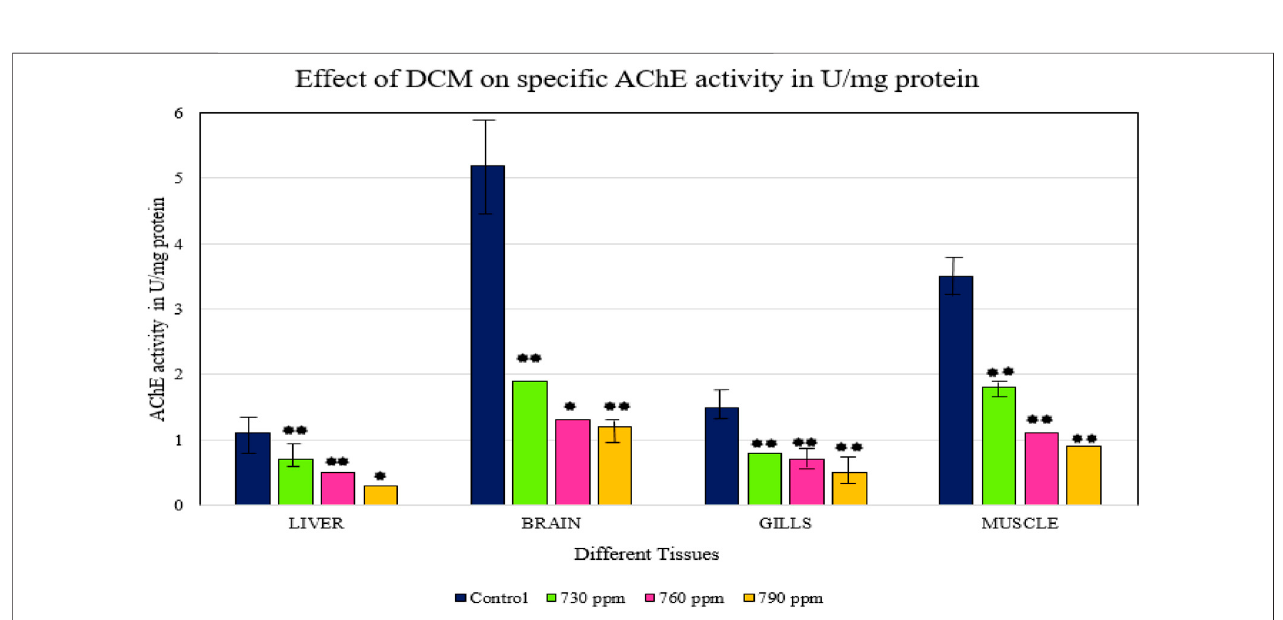
FIGURE 3 | Effect of DCM on speci fi c AChE activity (U/mg protein) in the different tissues of O . mossambicus. — p < 0.05, — p > 0.05.